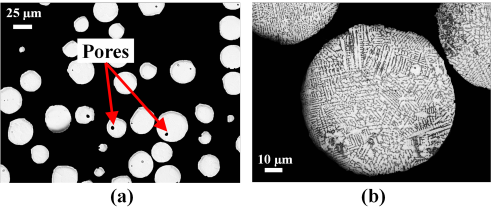
Figure 2. Cross-sectional OM image of the virgin IN718 powder: ( a ) polished, revealing the pores present inside the powder particles and ( b ) etched, highlighting the dendritic microstructure.